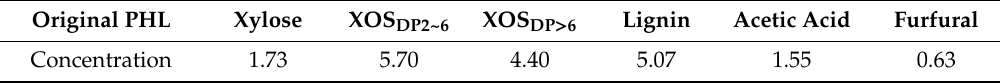
Table 1. Chemical compositions of the original PHL (g / L).